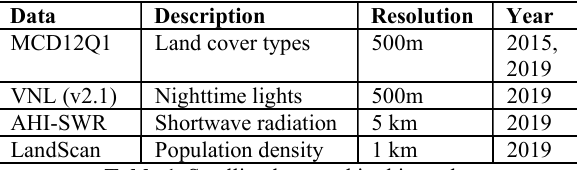
Table 1. Satellite data used in this